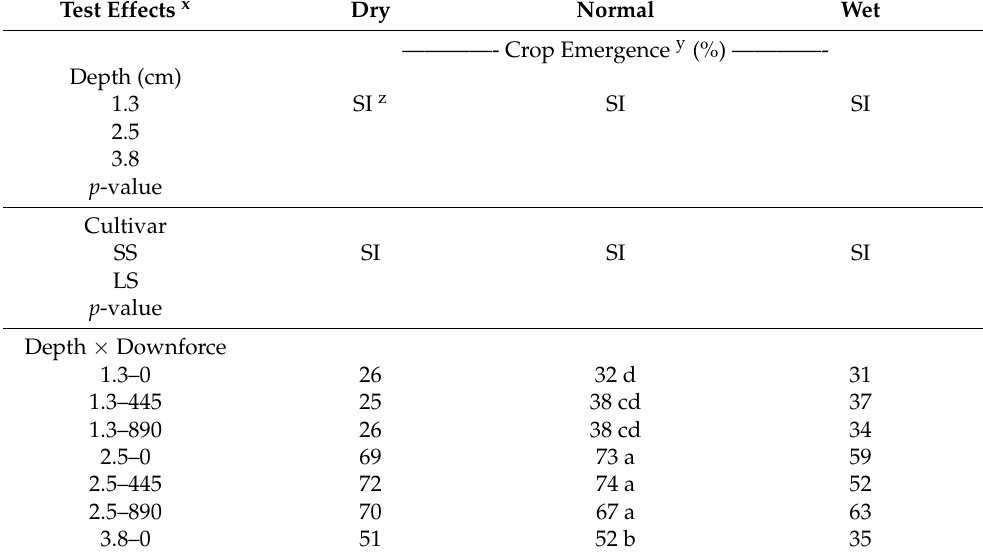
Table 7. Influence of seeding depth, cultivar, depth × downforce, depth × cultivar, and downforce × cultivar on crop emergence in different at-plant field conditions in